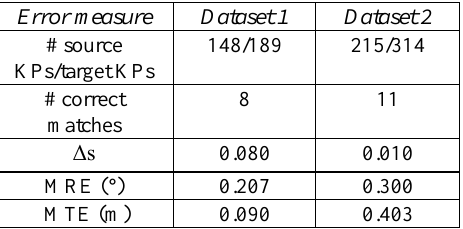
Table 2. Results for Height-map based